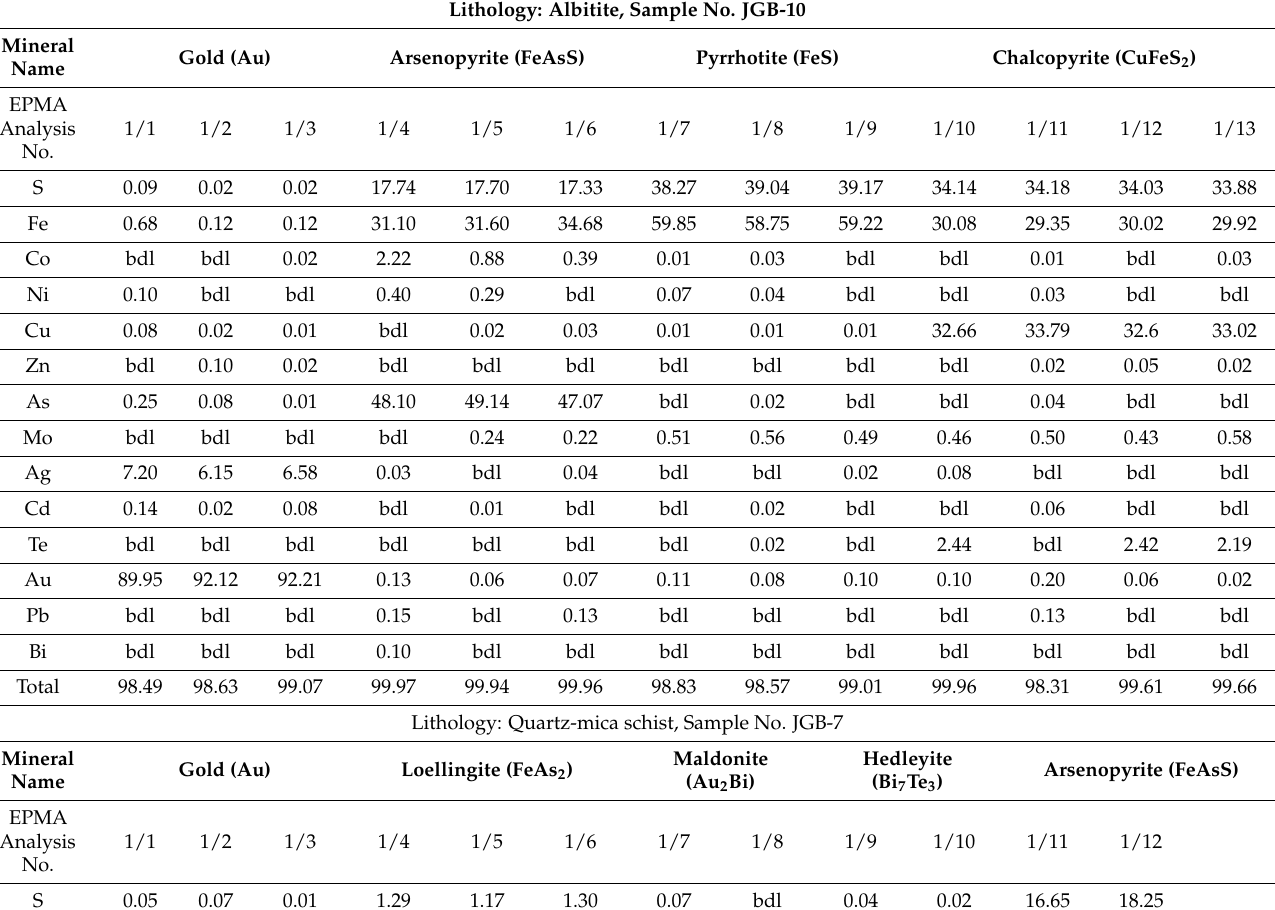
Table 1. EPMA data of Au, Au-Te, Au-Bi and sulfide phases (in Wt%) from the Jagpura gold-copper deposit, western